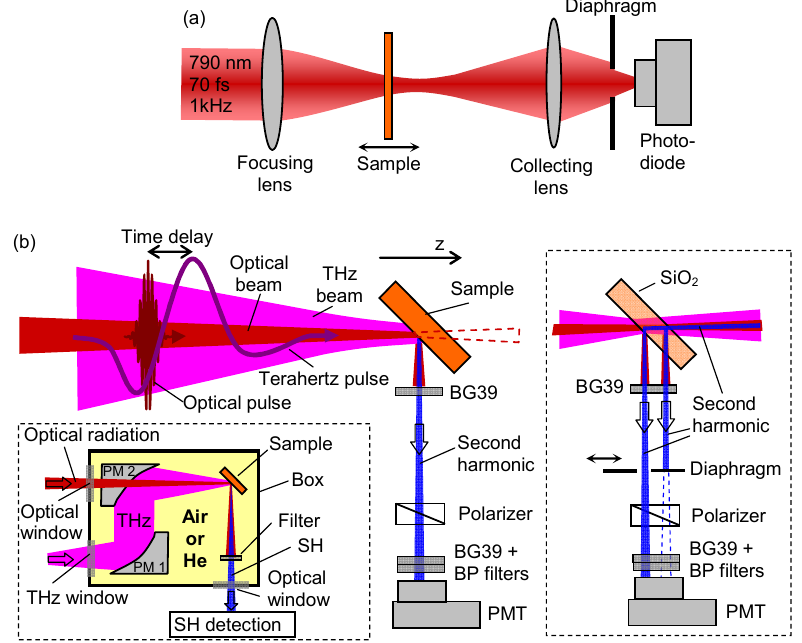
Figure 1. ( a ) Z-scan scheme for χ ( 3 ) ( − ω ; ω , − ω , ω ) measurement. ( b ) TFISHG scheme in reflection geometry for χ ( 3 ) ( − 2 ω ; ω , ω ,0 ) measurement. The left inset shows the arrangement of optical elements and the sample inside a box filled with air or helium. The right inset shows SH detection setup with a diaphragm for selective measurement of SH signals reflected from the entrance and exit surfaces of the fused quartz (SiO 2 ).